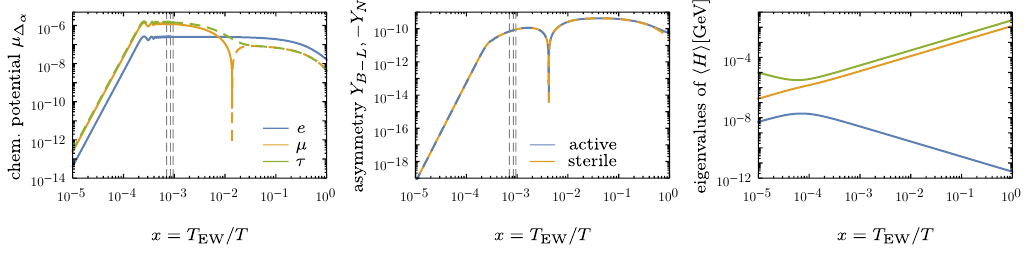
Figure 8 . Benchmark point III). Left: asymmetries in the individual active (cid:13)avours. Center: sum of asymmetries in the active (blue) and sterile (orange) (cid:13)avours. Right: eigenvalues of the e(cid:11)ective Hamiltonian h H i . Continuous (dashed) lines indicate positive (negative) values. The dashed vertical lines indicates the points in time when the oscillations among the heavy neutrinos are switched o(cid:11), see main text.